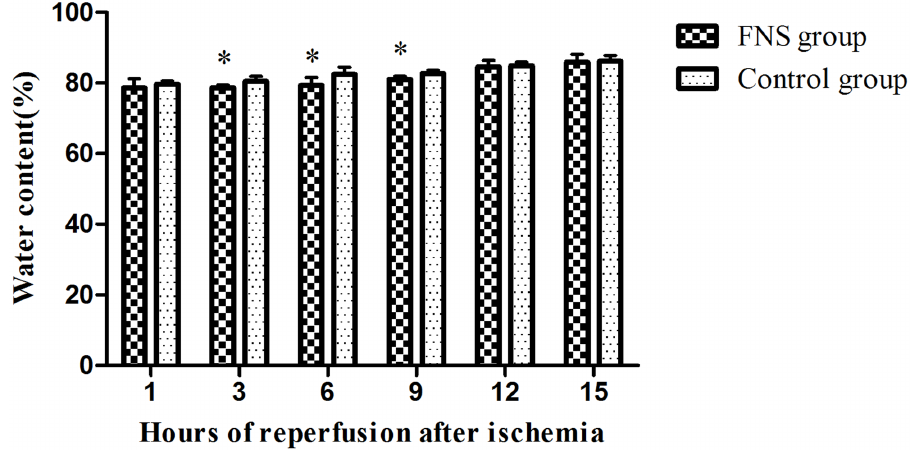
Fig 7. Brain water content of two groups. (A) The percentage of ischemic lesion area was represented as the ratio of the infarction area to the whole slice area. (B)Water content was calculated by (wet weight − dry weight) /wet weight × 100%. Results are expressed as the mean ± SD. * p < 0.05, vs the control group, n =